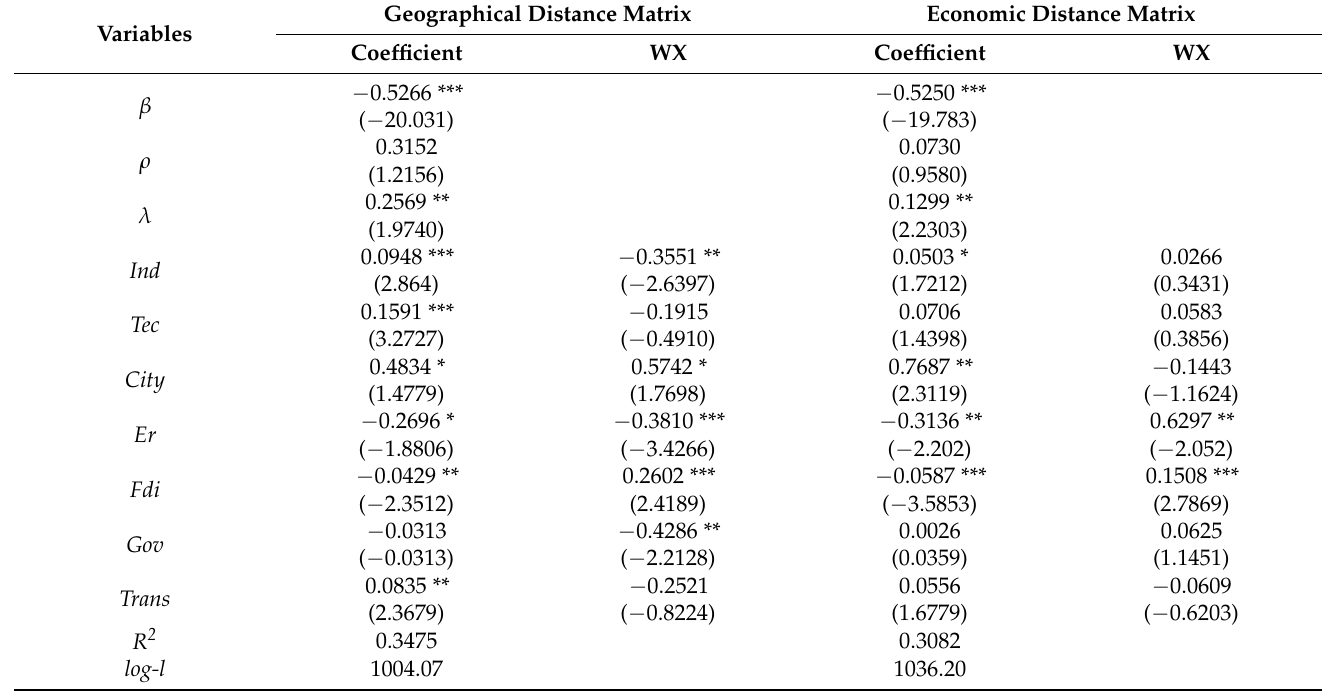
Table 8. Conditional β convergence estimation results of two spatial weight